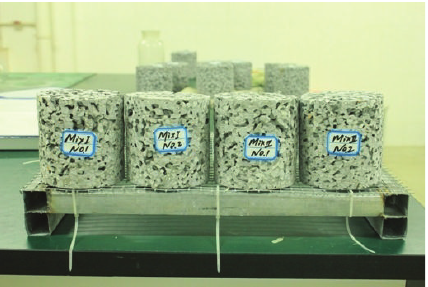
Figure 1: Pervious concrete cores for water permeability test.